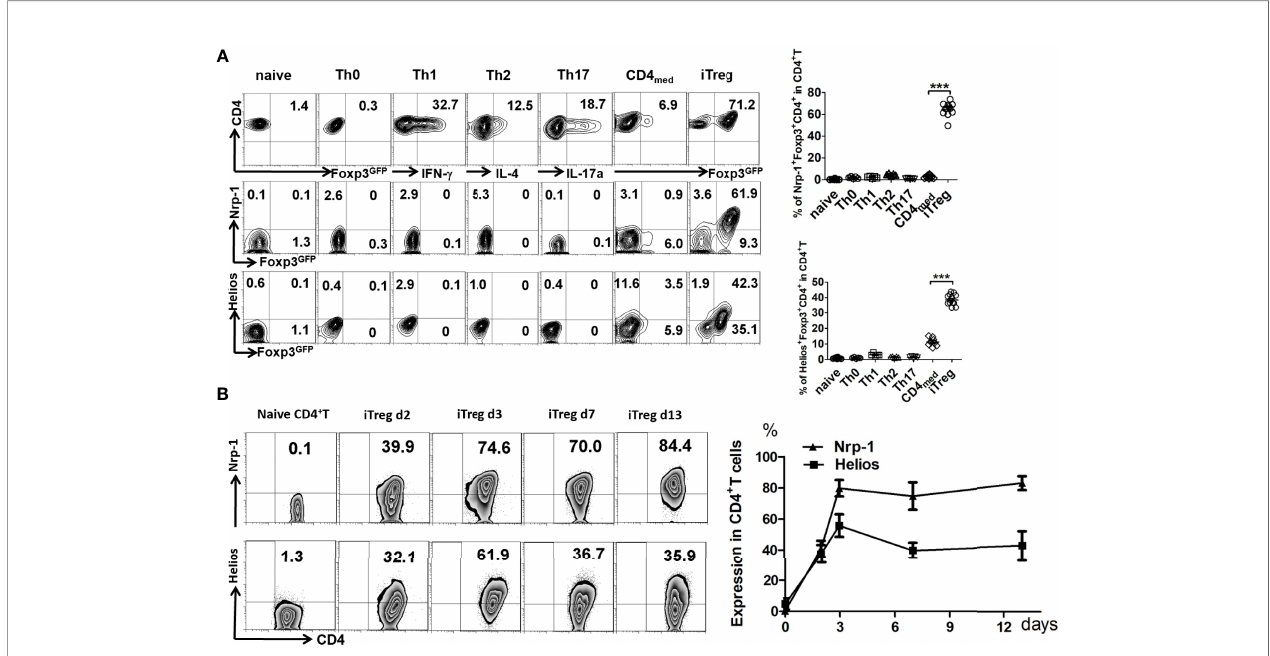
FIGURE 1 | Nrp-1 was highly expressed in induced CD4 + Treg in vitro . (A) The expression of Nrp-1 and Helios were measured in naïve CD4 + T cells, Th0, Th1, Th2, Th17, CD4 med , or iTreg by fl ow cytometry. Nrp-1, Helios, and Foxp3-GFP were analyzed together. Representative FACS plots and the summarized data (right) of three separated experiments were shown. (*** p <0.001). (B) Dynamic Nrp-1 and Helios expression in iTreg cells in vitro at different days. Representative data was